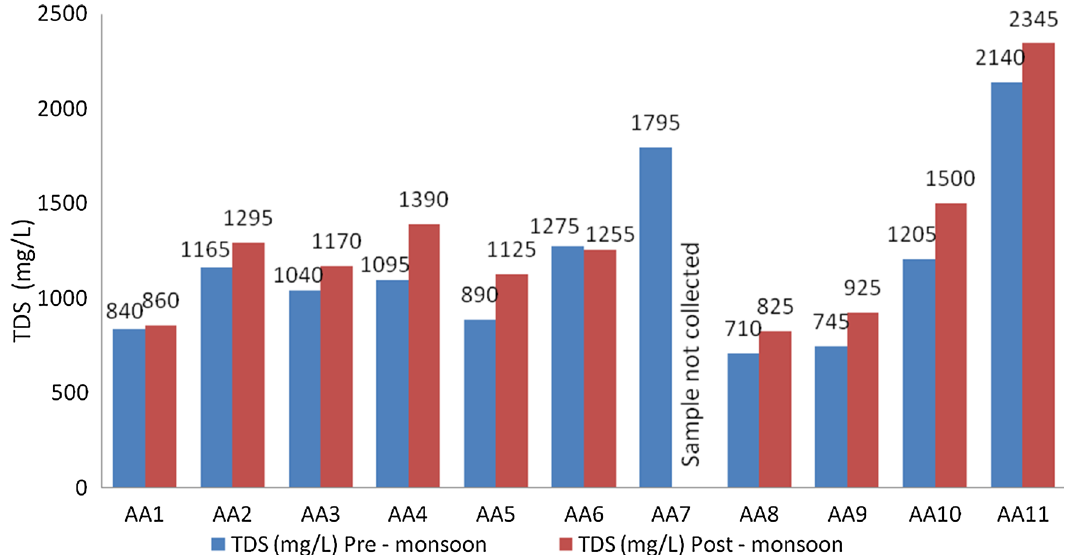
Fig. 9 TDS in samples BIS limit (2000 mg/L) collected from Ayodhya